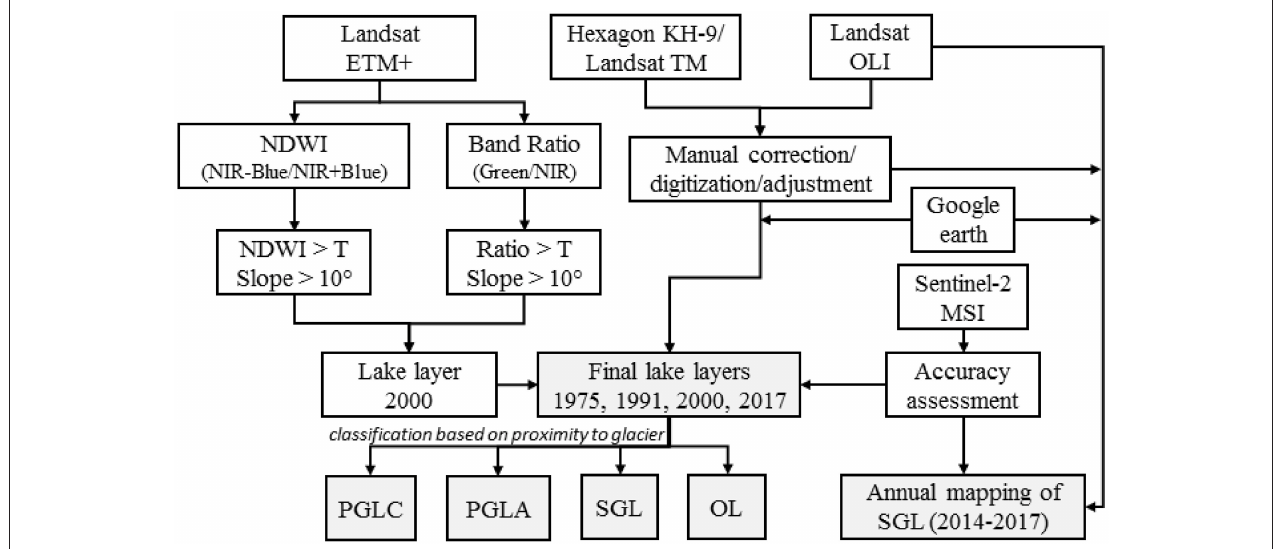
FIGURE 4 | Flowchart of lake mapping in glacial and high-altitude lakes based on Landsat images. The threshold (T) is determined empirically by visual inspection. SGL, supraglacial lakes; PGLC, peri/proglacial lakes in contact with glaciers; PGLA, peri/proglacial lakes away from glacier; OL, other